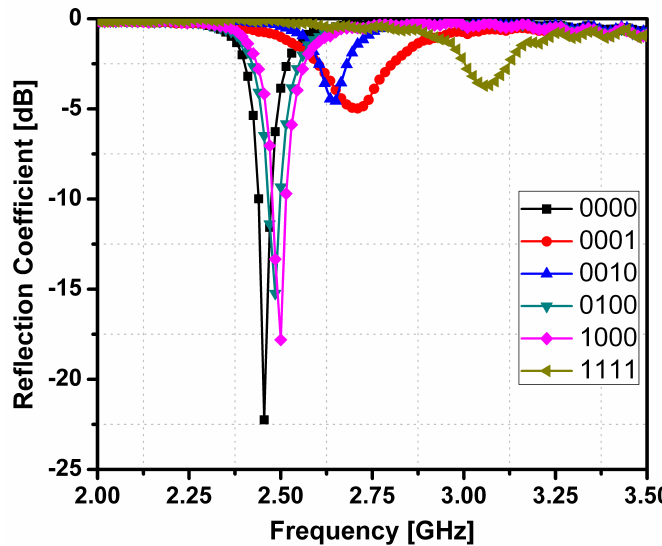
Figure 6. Measured Reflection Coefficients of Proposed SIW